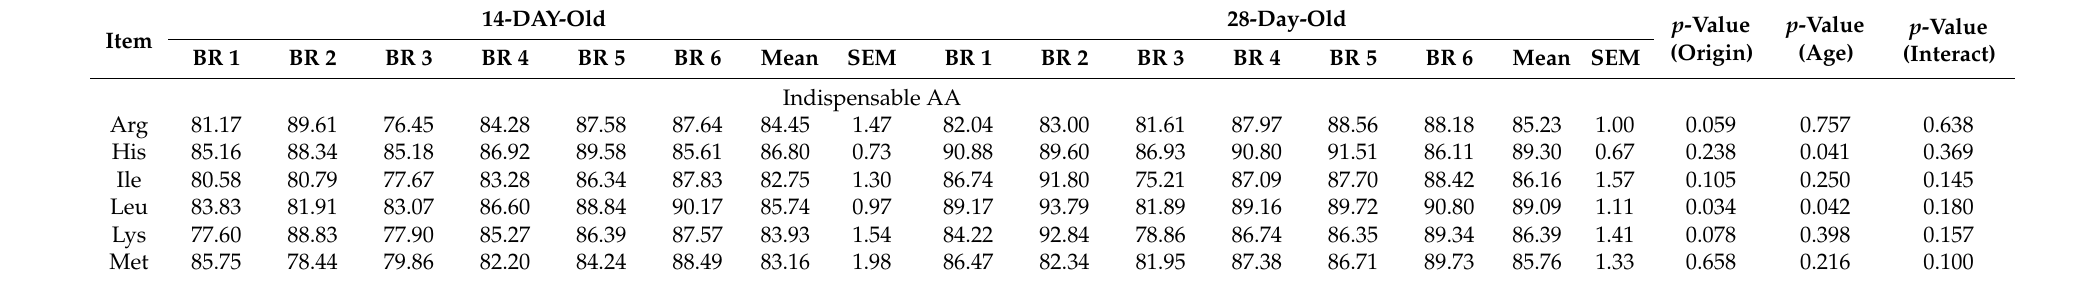
Table 8. Standardized amino acid digestibility of different sources BR in broilers